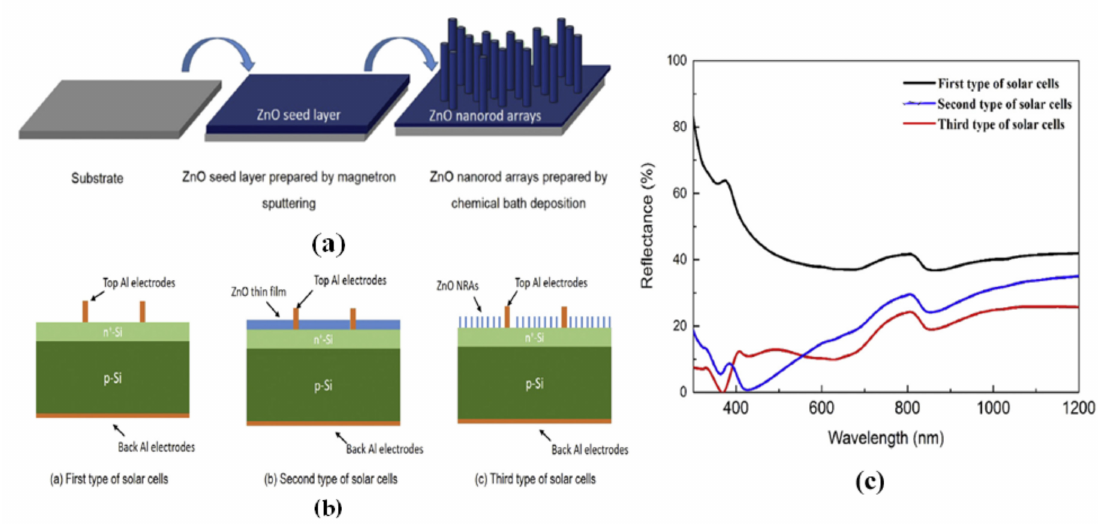
Figure 19. ( a ) Steps involved in the fabrication of ZnO nanorod arrays. ( b ) Schematic structures of fabricated three types of solar cells. ( c ) Variation of reflectance for the fabricated solar cells with respect to wavelength. Reprinted with permission [171]; 2017,